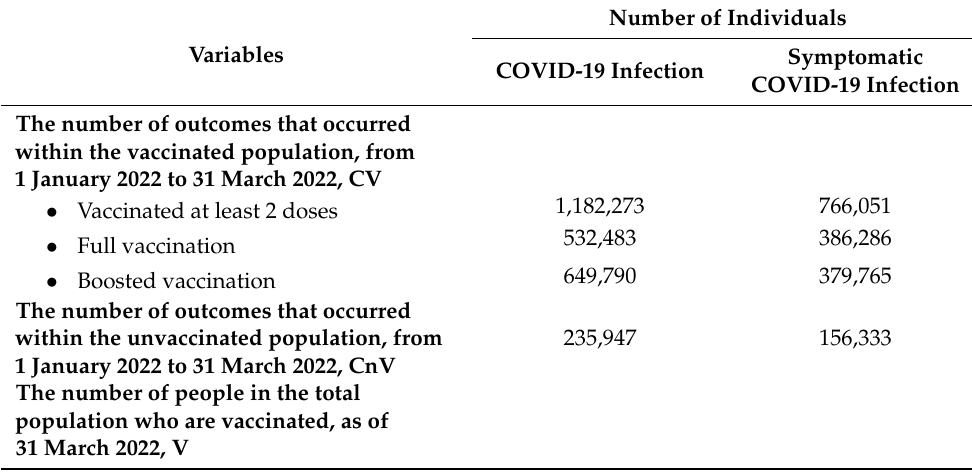
Table A1. Variables in the calculation of VE using screening